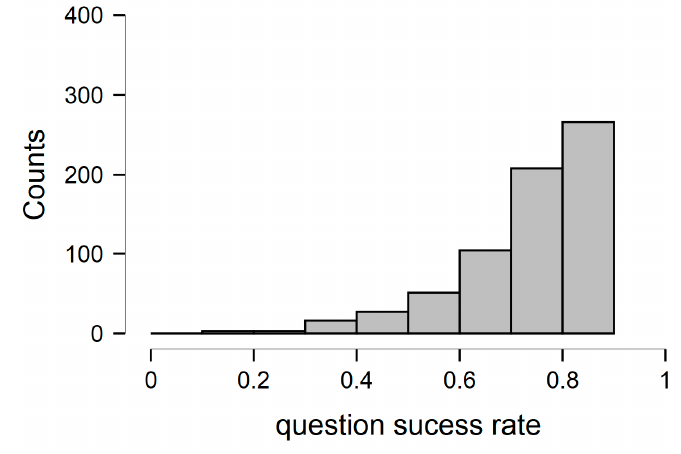
Figure 1. Question success rate histogram. Table 3. Expected point score.